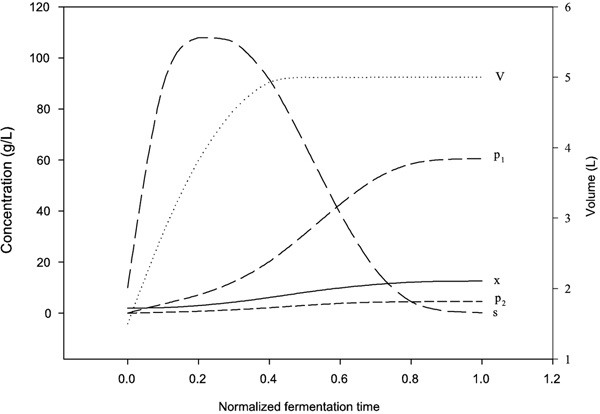
Dynamic behavior of the ethanol fed-batch fermentation model. Time profiles of cell mass (x), glucose (s), ethanol (p1), glycerol (p2), and the working volume (V) for the ethanol fed-batch fermentation computed using the optimal feed rate F* and the feed glucose of 200 g/L. The horizontal scale is in normalized fermentation time (t/t
f
).